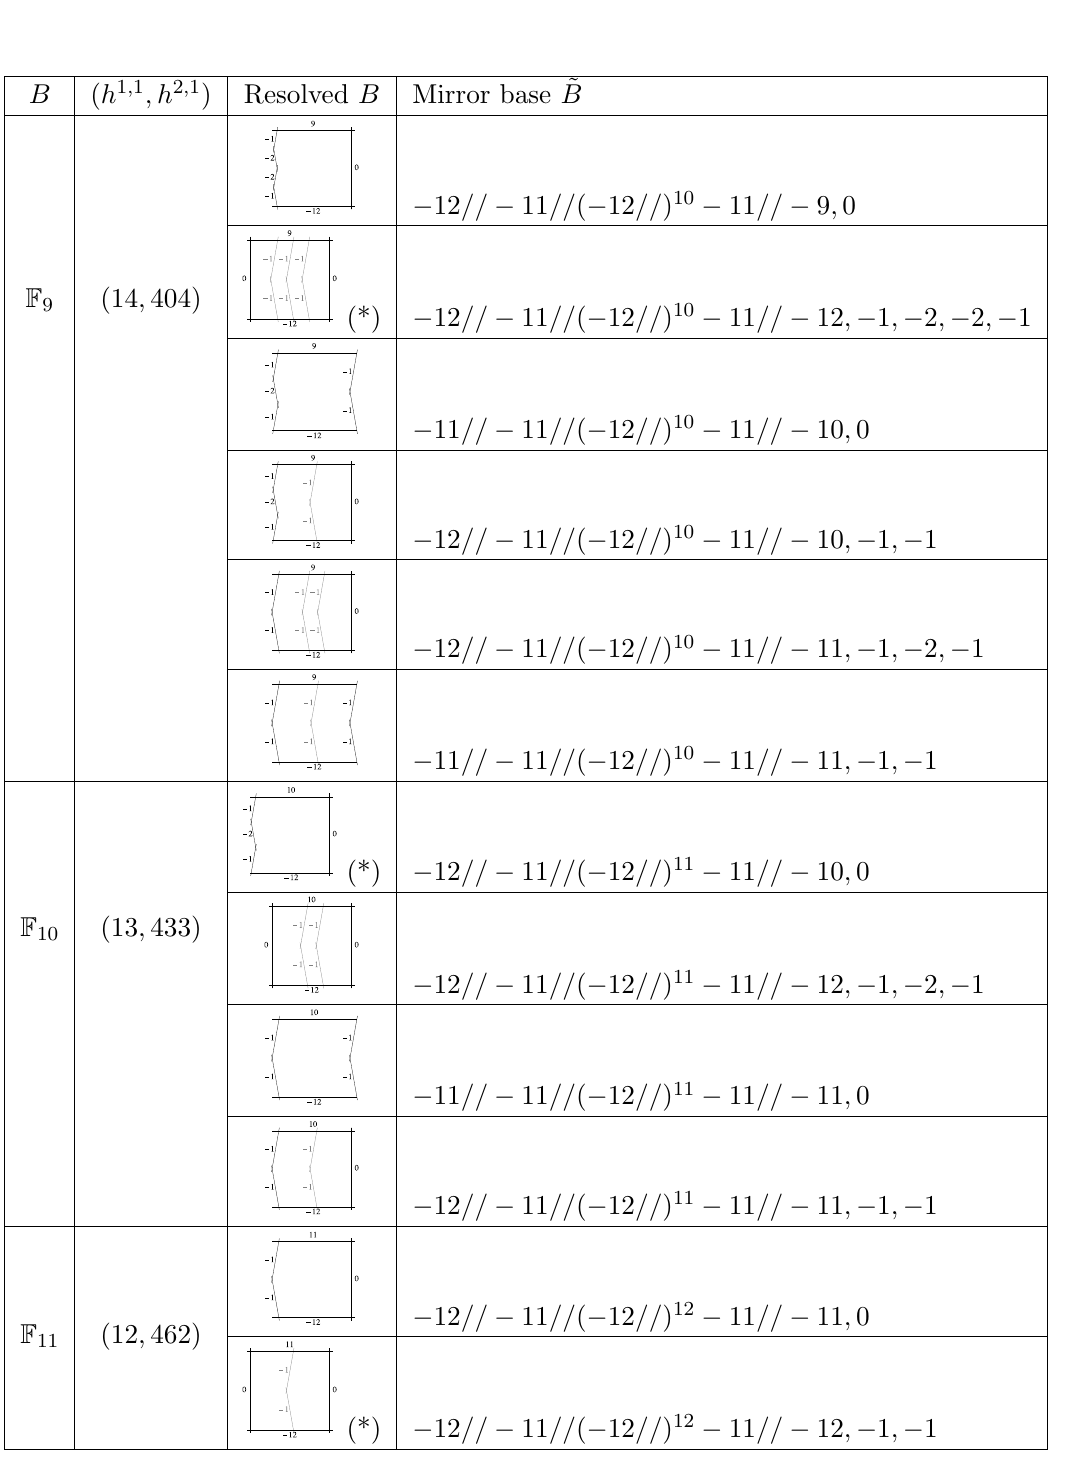
Table 2 . For each Hirzebruch base B = F n , n = 9 ; 10 ; 11 the Hodge numbers of the generic elliptic (cid:12)bration X over resolved B , the toric structure of the resolved base and the base ~ B of the mirror Calabi-Yau threefold ~ X . The bases marked with (*) are resolved at generic non-toric points, and correspond to the naive stacking models with the given Hirzebruch base, while the other bases are resolved at combinations of toric and non-toric points.